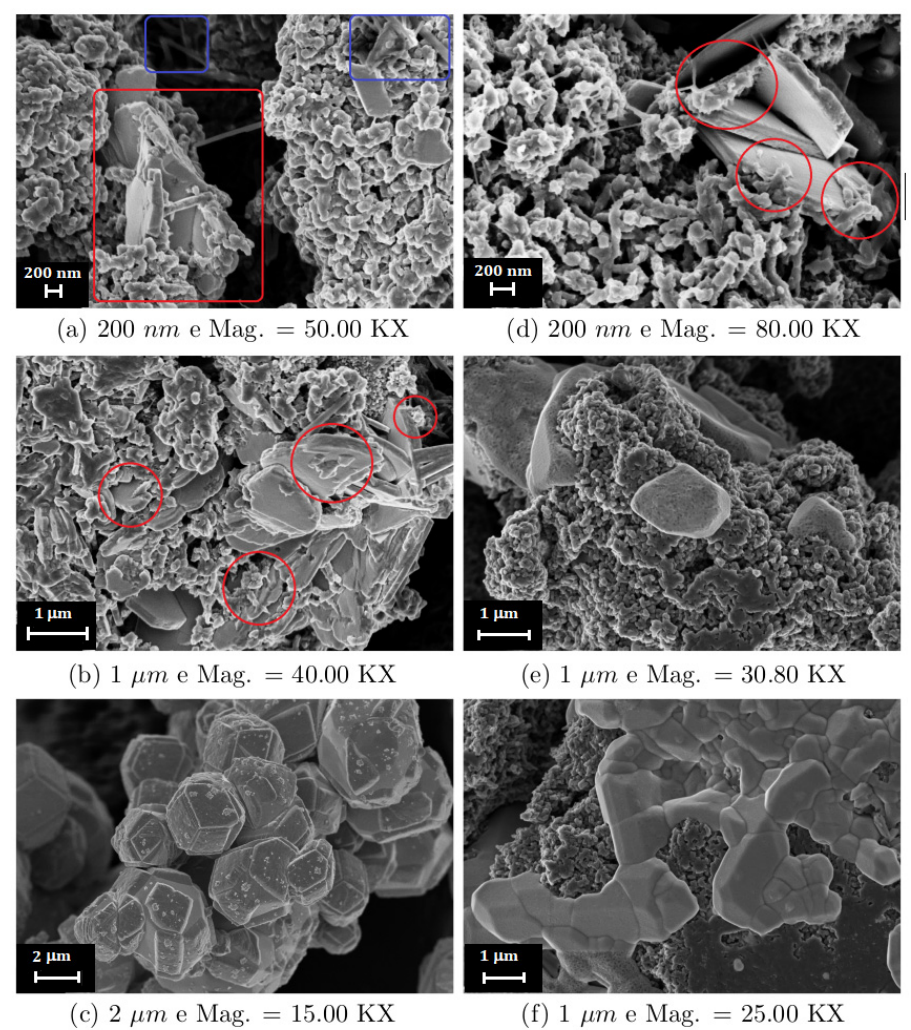
Figure 12. ( a ) Microplate morphology of the WO 3 · 2H 2 O phase coexisting with ES–PANI and aniline hydrochloride (highlighted in blue); ( b ) Physical interaction between ES–PANI and WO 3 · 2H 2 O phases (highlighted in red); ( c ) Regular morphology of metallic W; ( d – f ) PW 2 nanocomposite morphology showing the physical interaction between WO 3 · 2H 2 O microplates and ES–PANI